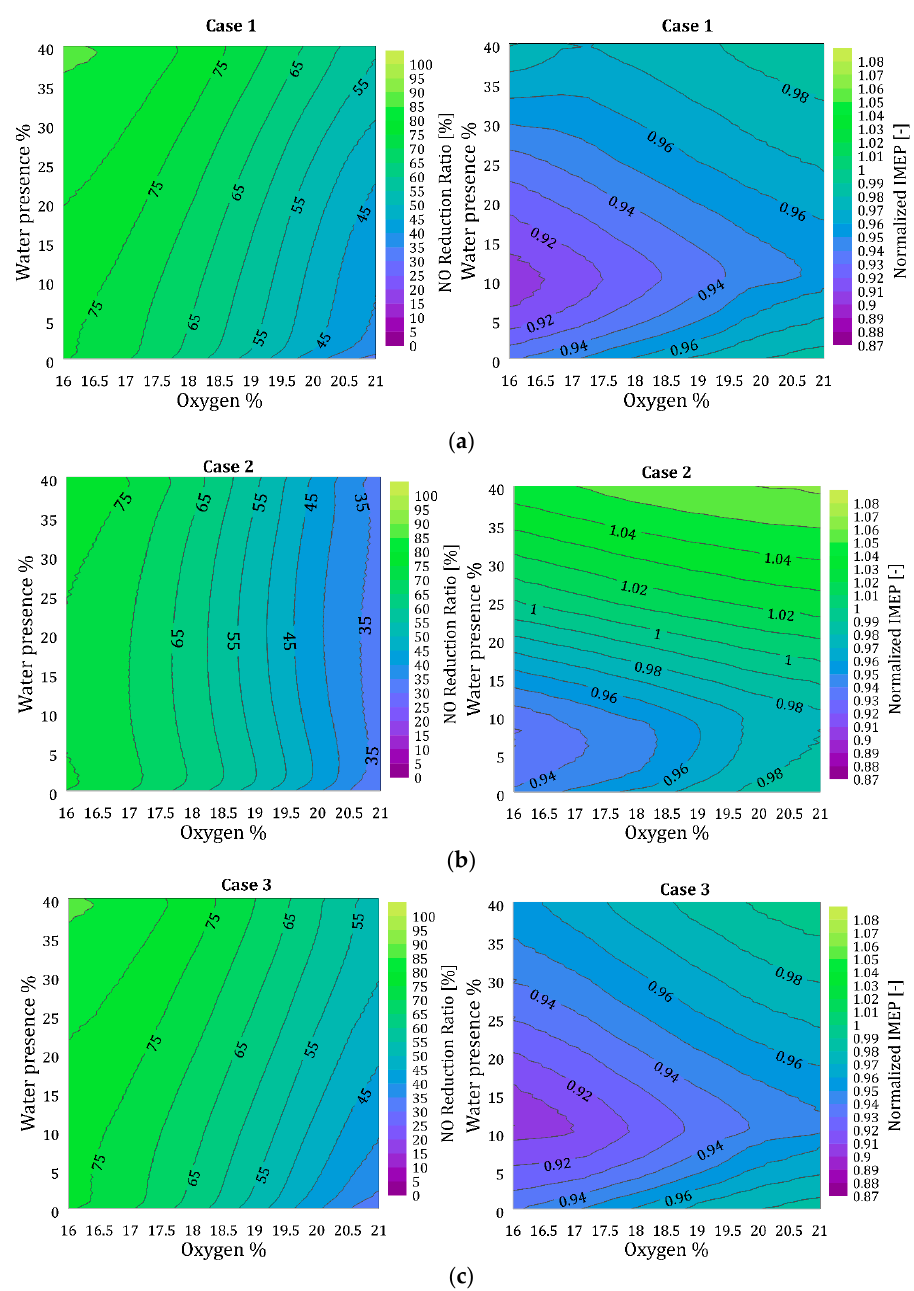
Figure 19. NO reduction and IMEP calculations for EGR–WFE combinations: ( a ) injection duration, ( b ) the pressure case, and ( c ) the diameter case.